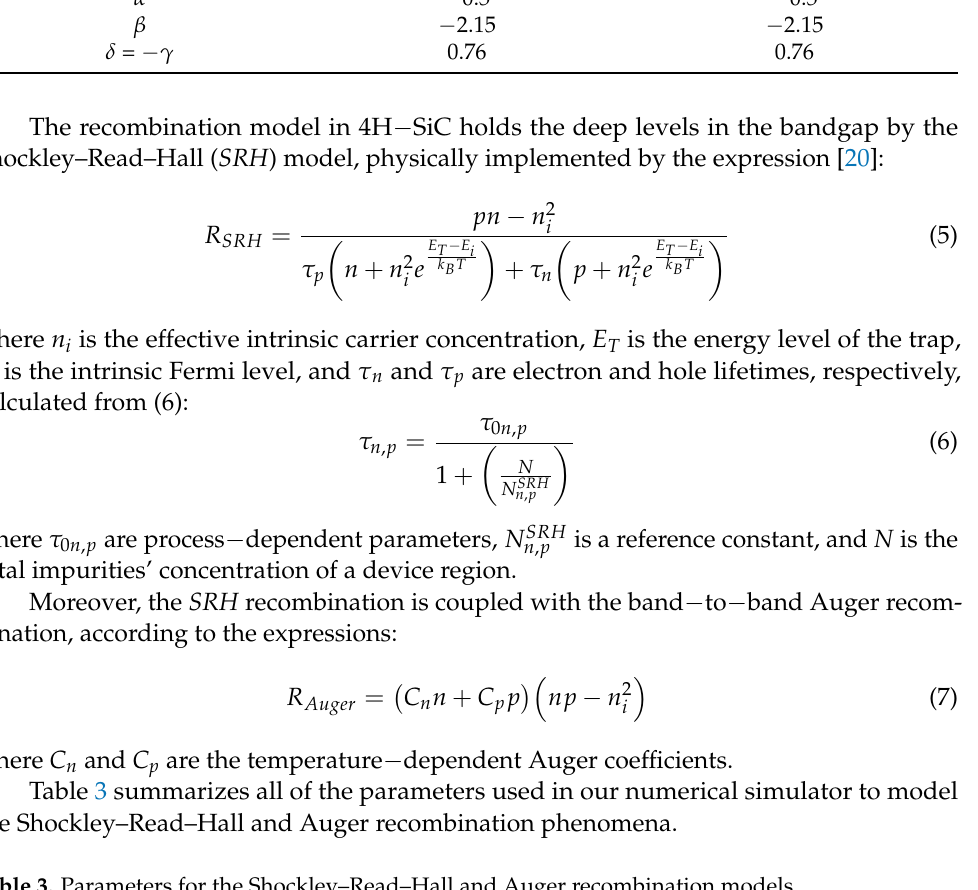
Table 3. Parameters for the Shockley–Read–Hall and Auger recombination models.